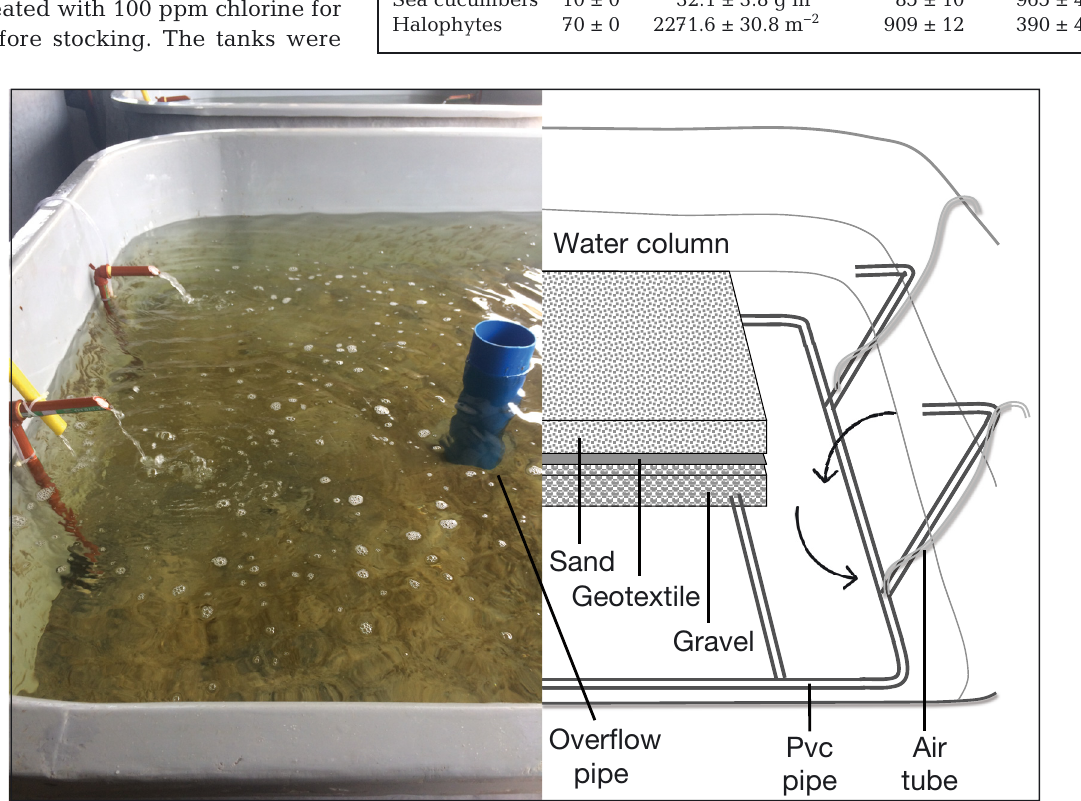
Fig. 2. Image and schematic of sea cucumber tank with airlift system. Arrows indicate the general direction of water flow down through the sediment and up through the airlift